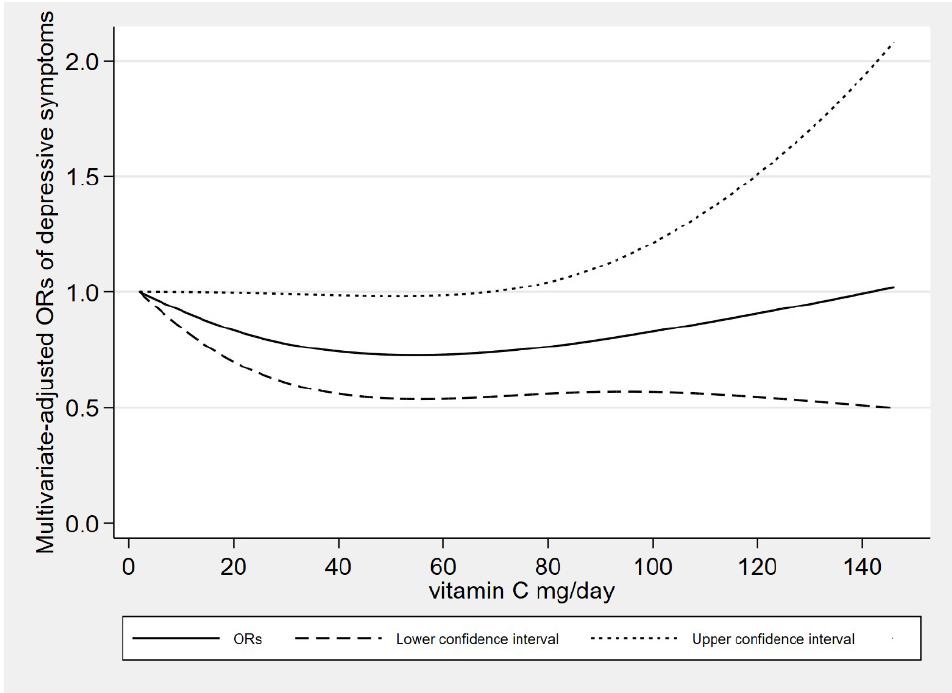
Figure 3. The results of dose response between dietary vitamin C intake derived from vegetables and depressive symptoms.